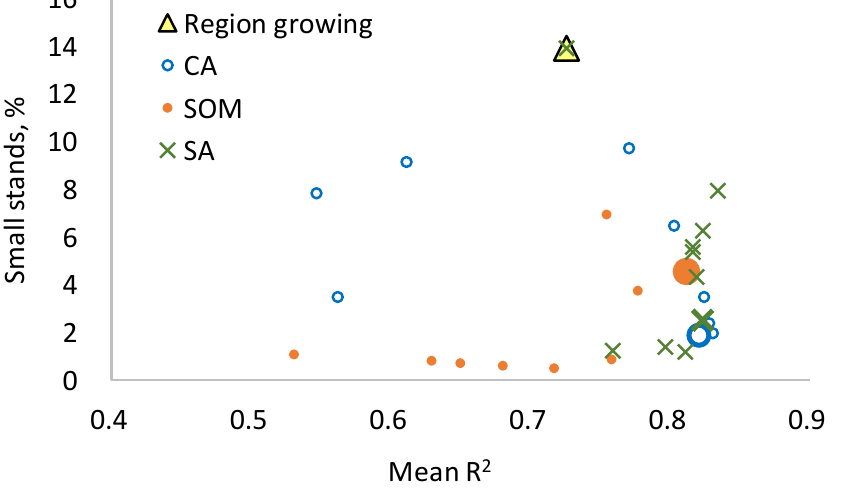
Figure 8. Relationship between the mean R 2 of the LiDAR metrics ( HP95 , AH5 , IV ) and the percentage of segments smaller than 0.3 ha when CA, SOM, and SA were used with different parameter values.